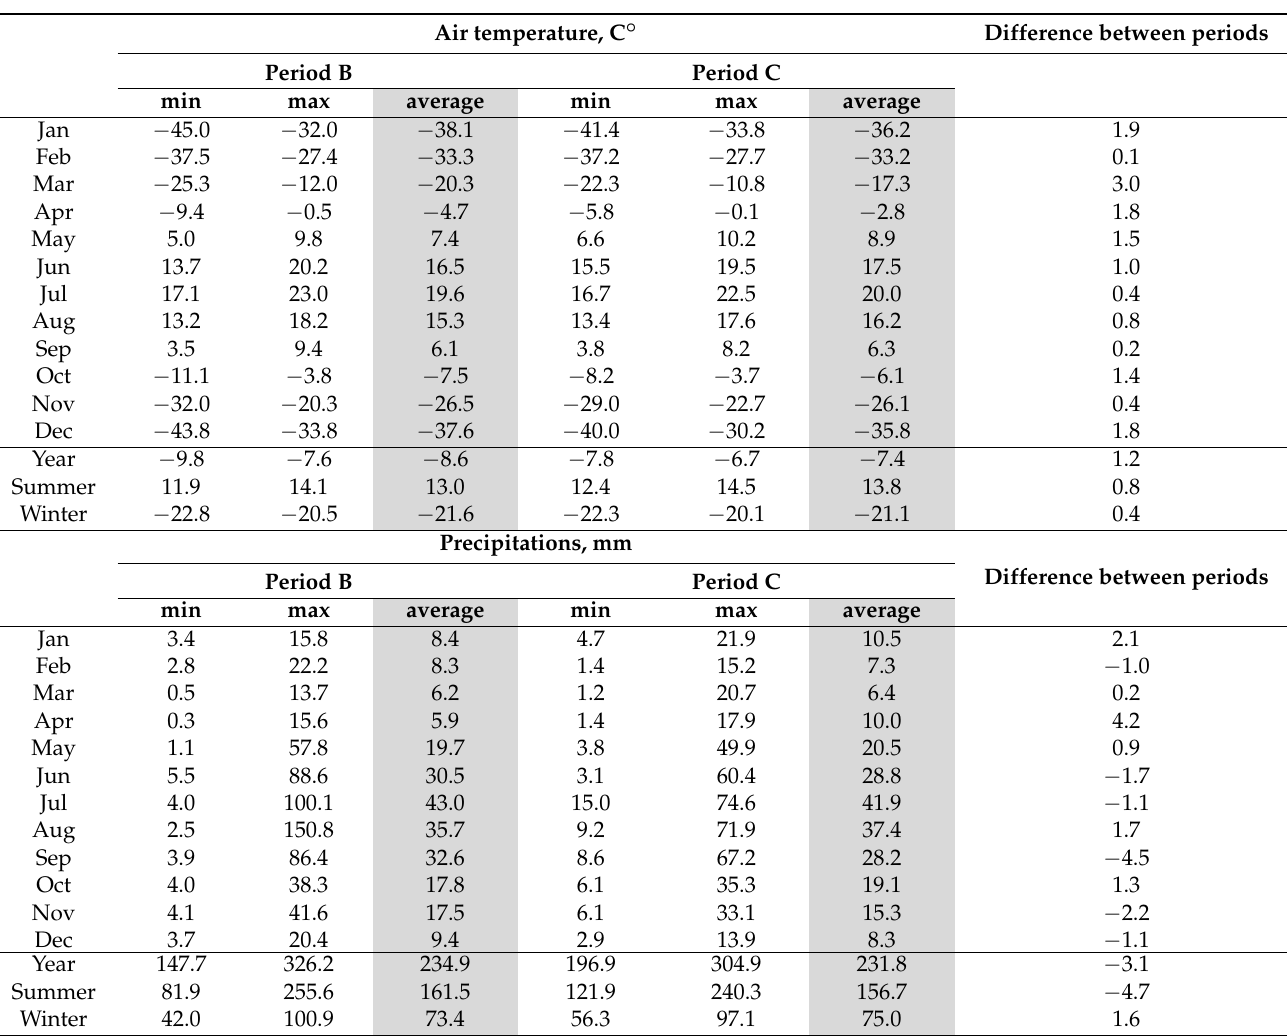
Table 1. Characteristics of climate change during different periods of mean annual air temperature